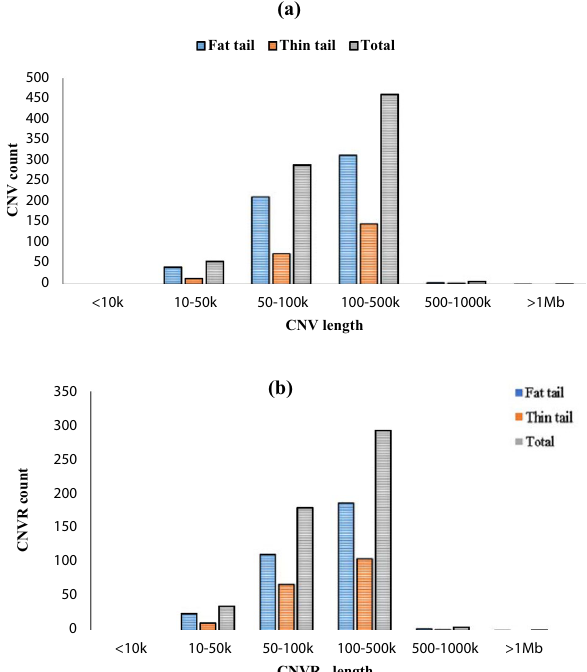
Figure 2. The distribution of CNVs size ( a ) and CNVRs size ( b ) in in fat and thin tail